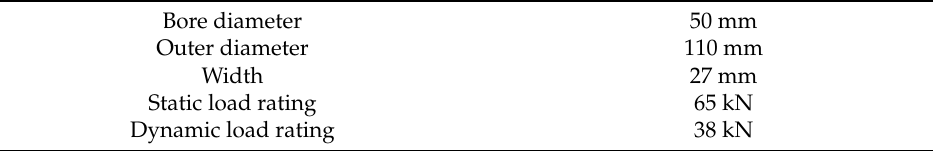
Table 2. 6310 SKF bearing details.